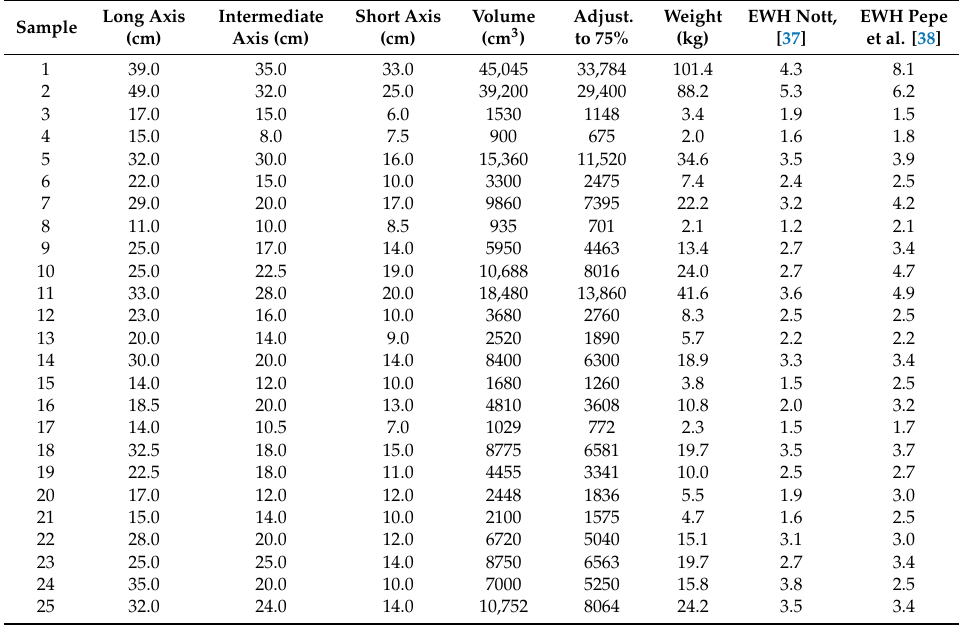
Table 4. Quantification of boulder size, volume, and estimated weight from the Pleistocene (MIS 5e) conglomerate at site 4 at Ponta do Castelo, from the southeast end of Santa Maria Island (see map, Figure 1b). The standard density of basalt at 3.0 gm / cm 3 was applied uniformly in order to calculate wave height for each boulder. EWH: estimated wave height (in meters), calculated from equations in Nott [37] and Pepe et al. [38]. See the methods Section 3.2. (hydraulic model).